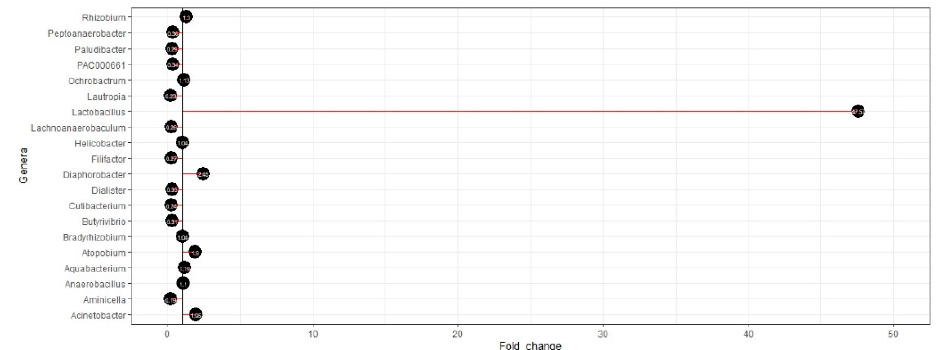
Figure 4. Diverging lollipop chart for differences in abundances for genera that were detected using compositionality corrected by renormalization and permutation (CCREPE). The fold change for each genus was calculated by dividing the mean abundance in cases by that of the controls.